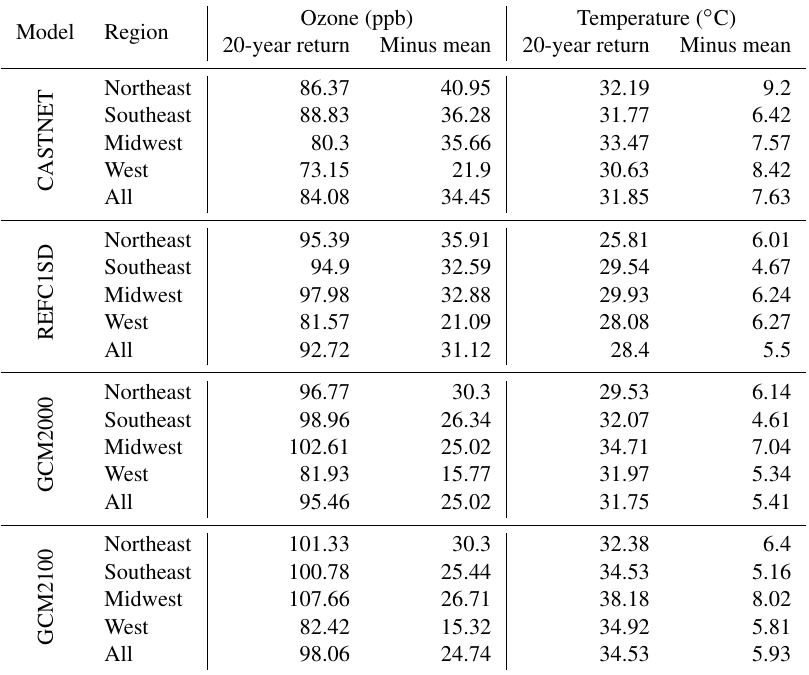
Table 3. Rescaled data. The 20-year return levels for MDA8 ozone (ppb) and daily maximum temperature ( ◦ C) (first and third columns) at the CASTNET sites and for the CESM1 REFC1SD simulation, the GCM2000 simulation and the GCM2100 simulation. The models are sampled only at the CASTNET stations. The 20-year return levels for ozone and temperature minus their averages (second and fourth